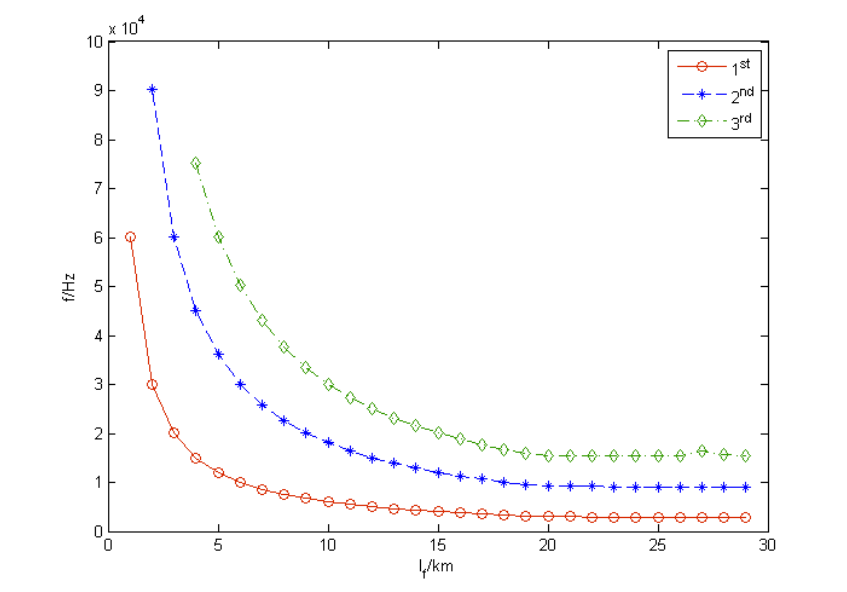
Figure 3. The relationship between the harmonic frequencies and fault